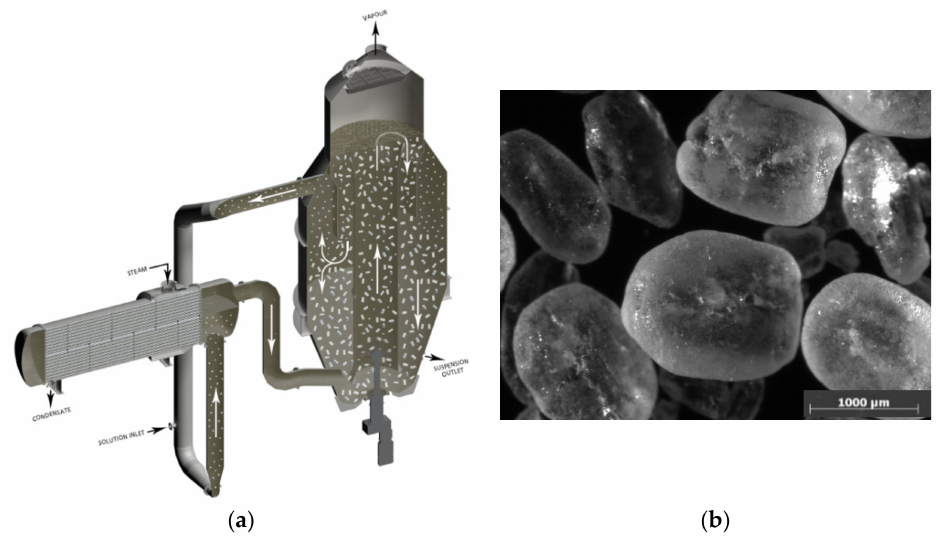
Figure 9. ( a ) Scheme of an industrial DTB crystallizer, by GEA Messo GmbH. ( b ) Crystals from the industrial DTB crystallizer (crystal size d´ = 1980 µ